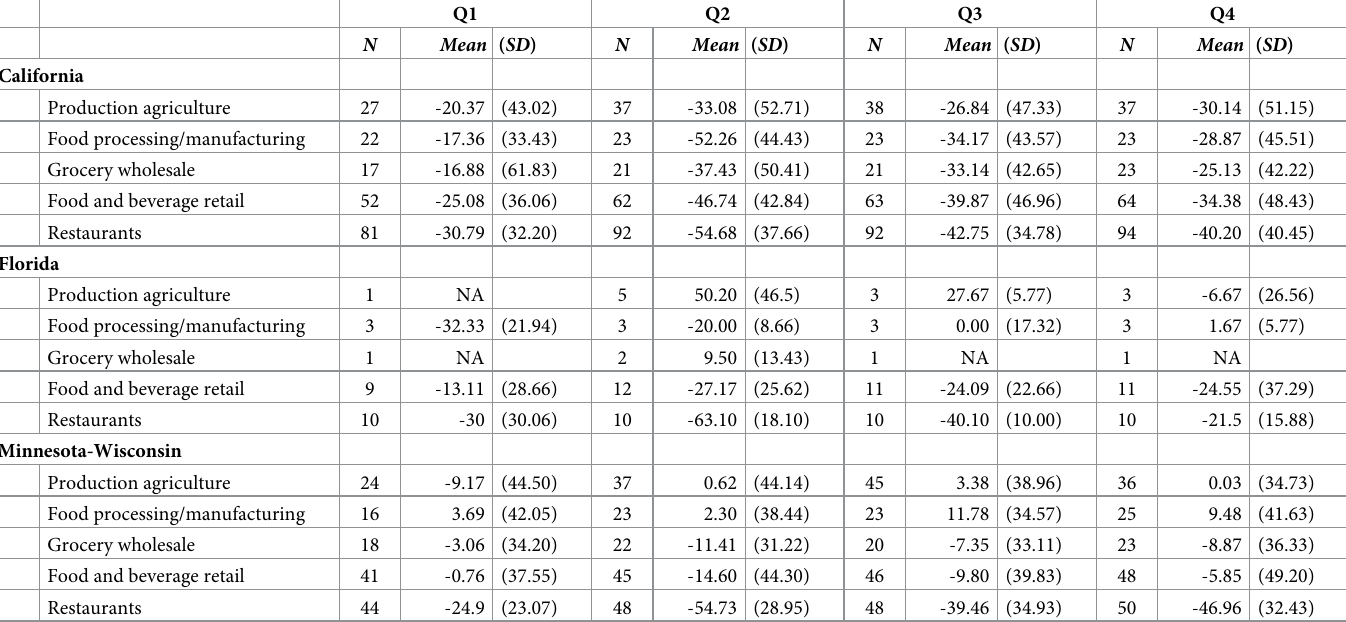
Table 4. Summary of changes in sales revenue in 2020, by quarter, supply chain segment, and study